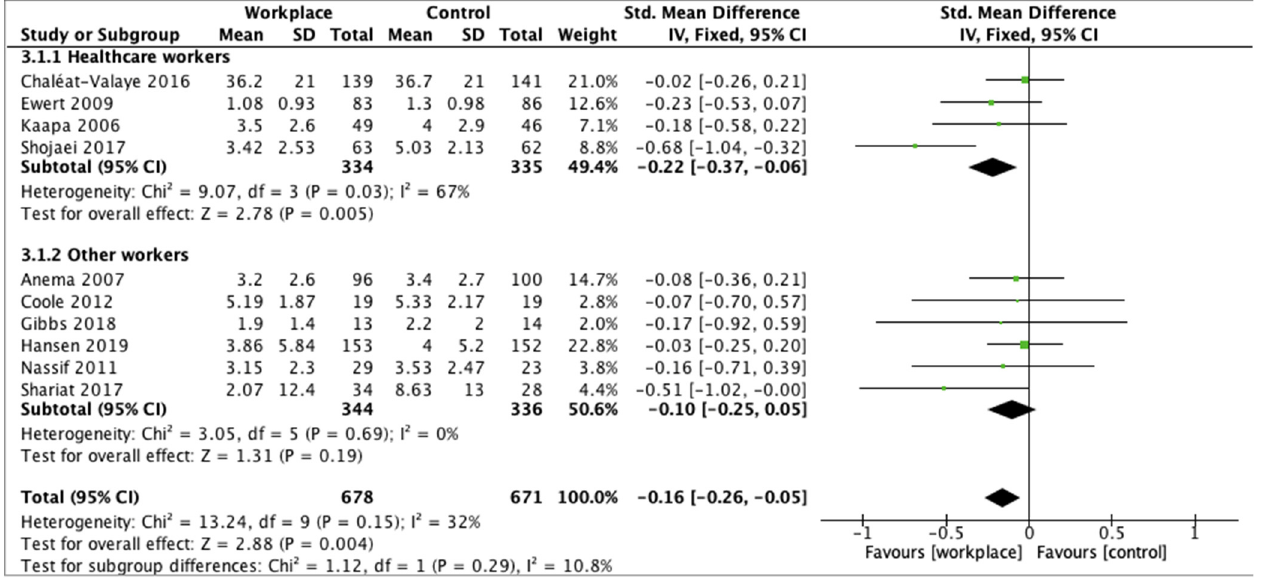
Figure 7. Subgroup analysis for low back pain.